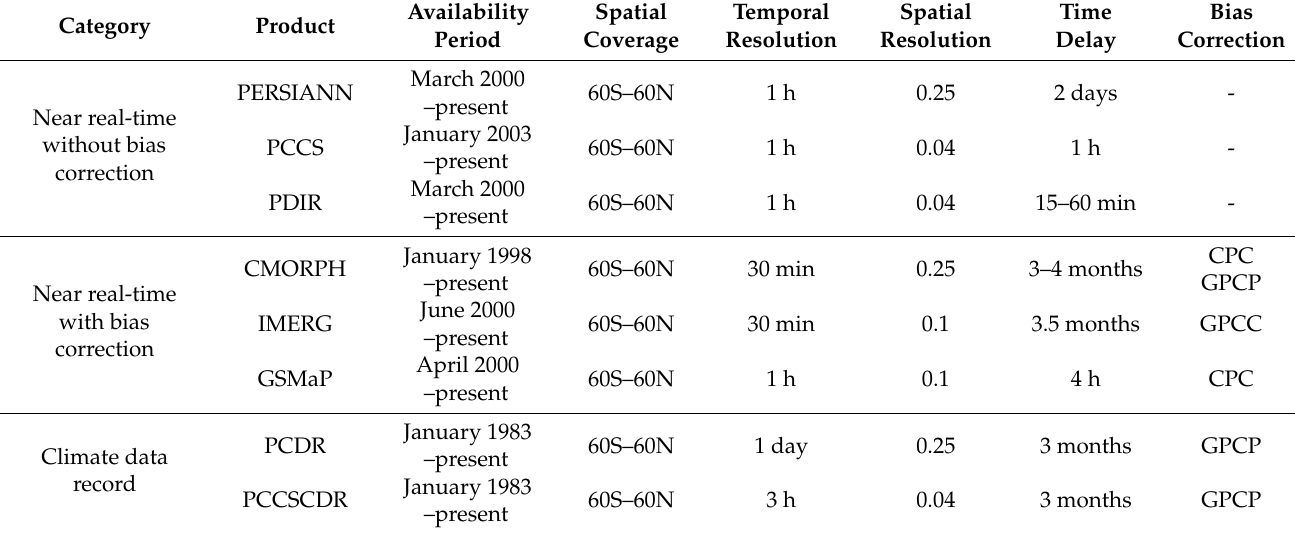
Table 1. Satellite precipitation estimates (SPEs) used in this study. GPCP: Global Precipitation Climatology Project dataset; CPC: Climate prediction center dataset; GPCC: Global Precipitation Climatology Centre